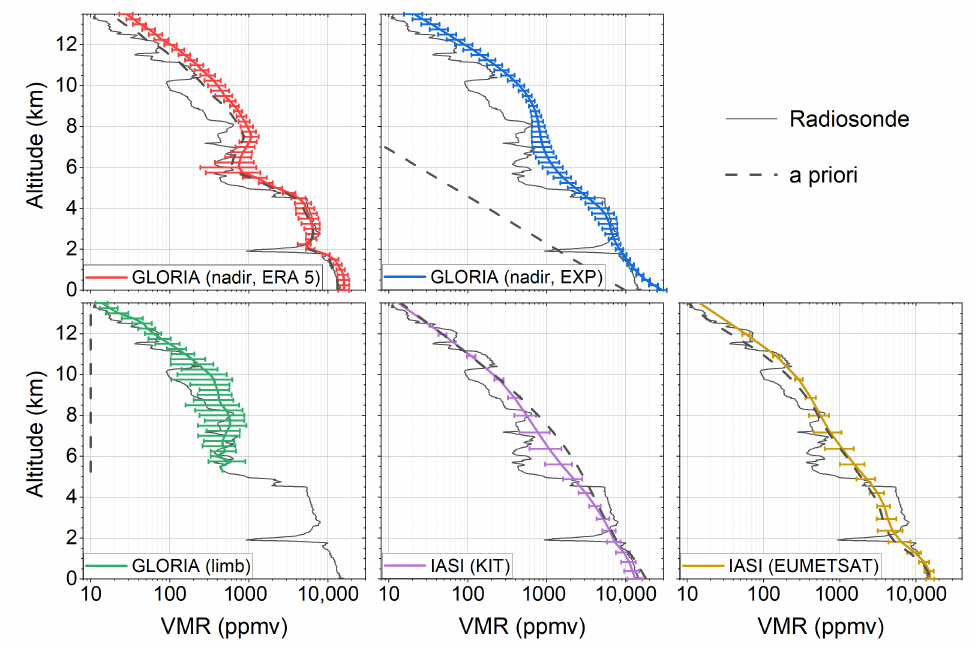
Figure 9. Same profiles as in Figure 8 with 1- σ variability of the averaged profiles as error bars and the associated mean a priori profile as black dashed